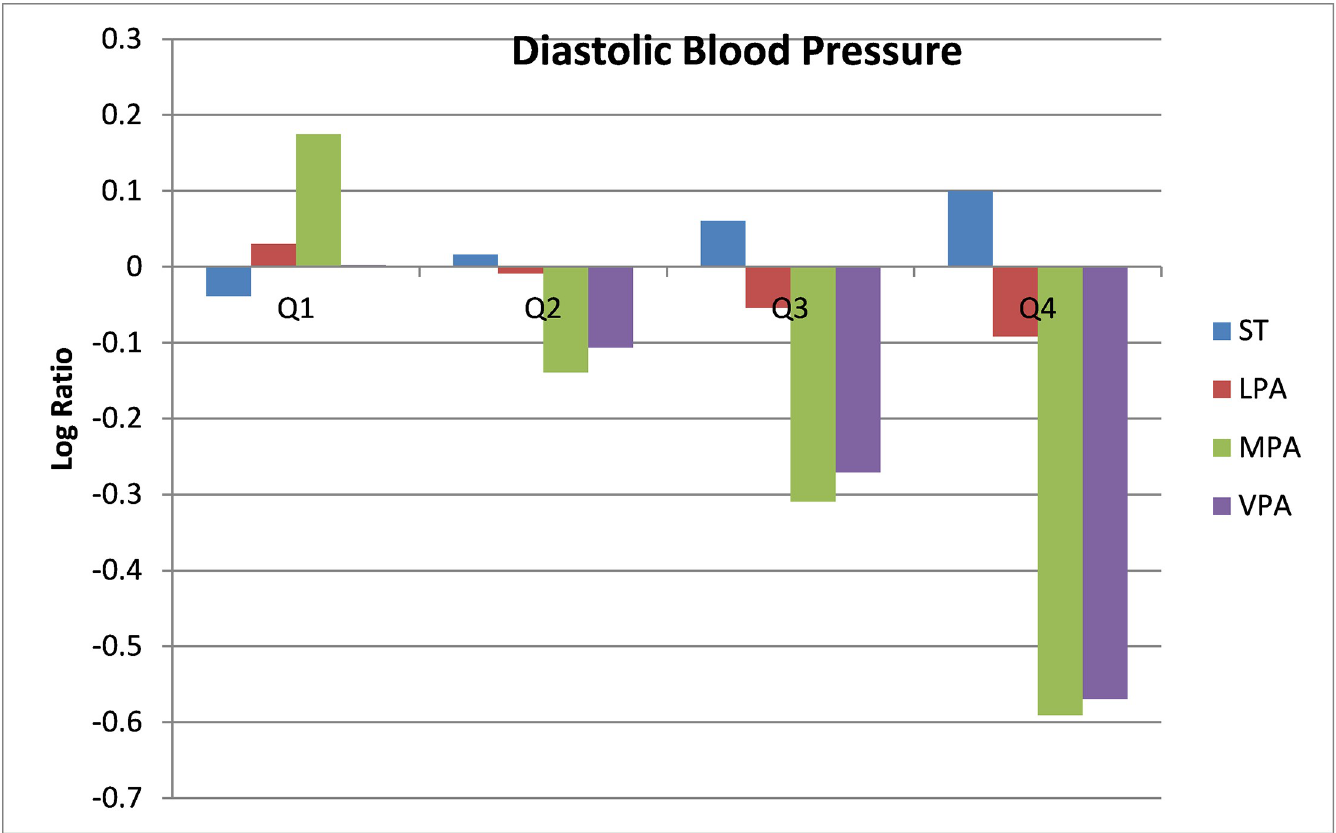
Fig 3. Compositional geometric mean bar plots comparing the compositional mean of the entire sample with the compositional mean of diastolic blood pressure quartiles subgroups for sedentary time (ST), light-intensity physical activity (LPA), moderate-intensity physical activity (MPA), and vigorous-intensity physical activity